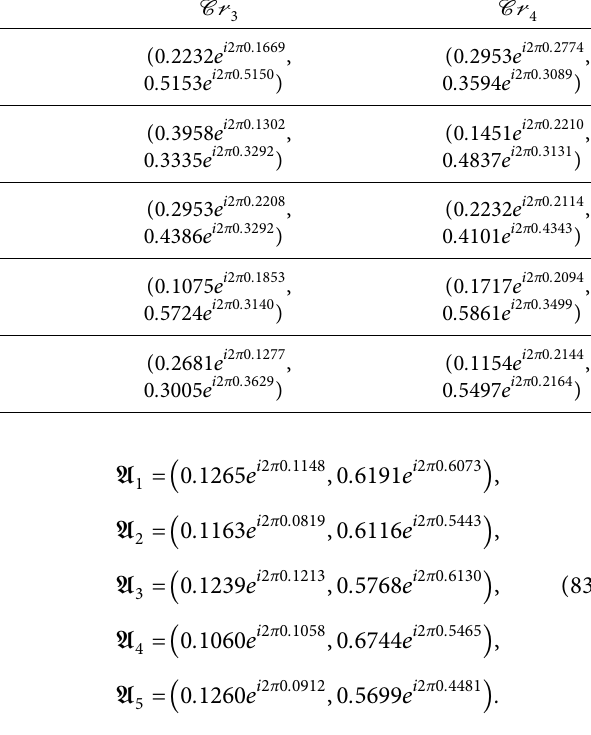
Table 4: Collective complex intuitionistic fuzzy decision matrix Ὤ � [ L